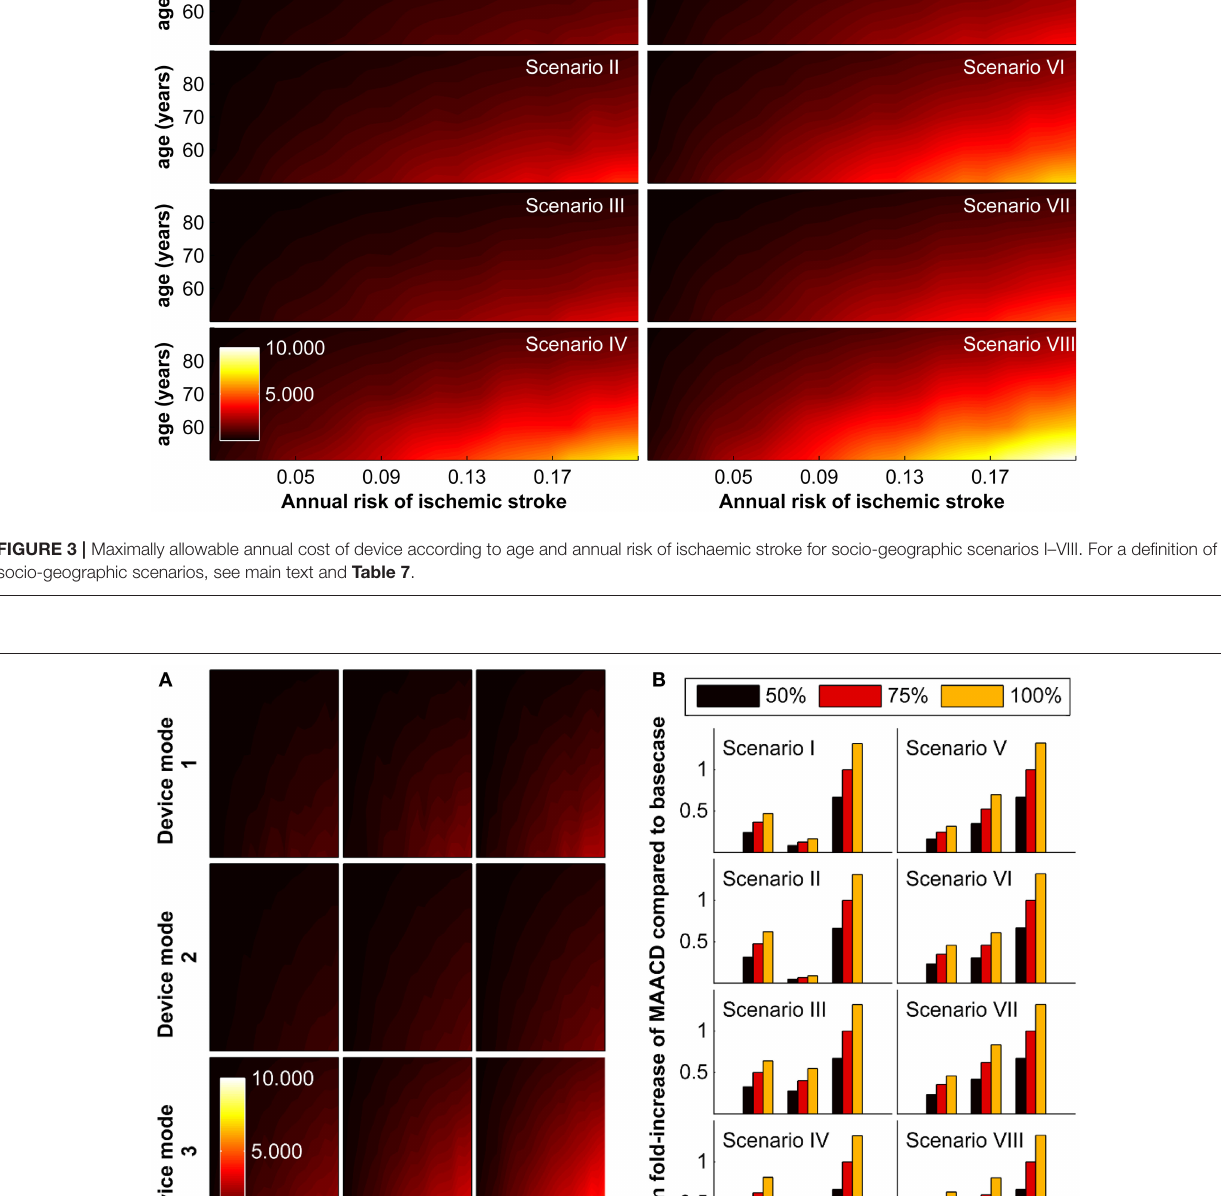
Frontiers in Neurology |